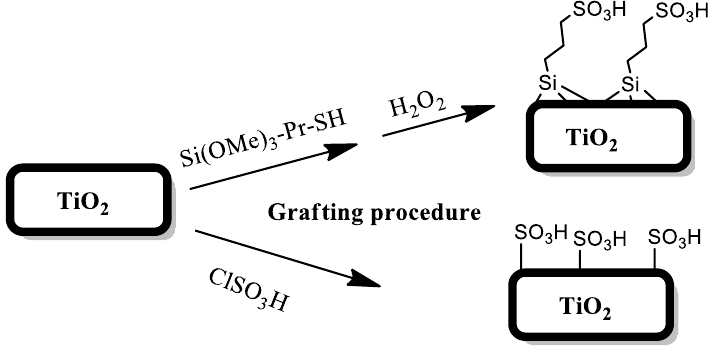
Figure 3. Grafting procedure for the synthesis of TiO 2 catalysts.